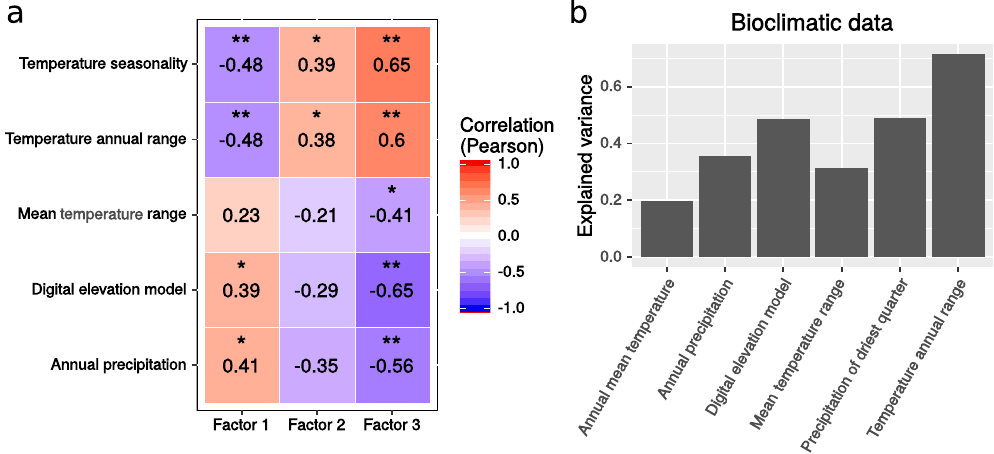
Figure 4. Phenotypic and genomic patterns correlate with bioclimatic variables. ( a ) Correlations between bioclimatic variables and Factors of Syrian phenotype data ( * p-value < 0.05; ** p-value < 0.01). ( b ) Genomic heritability of bioclimatic